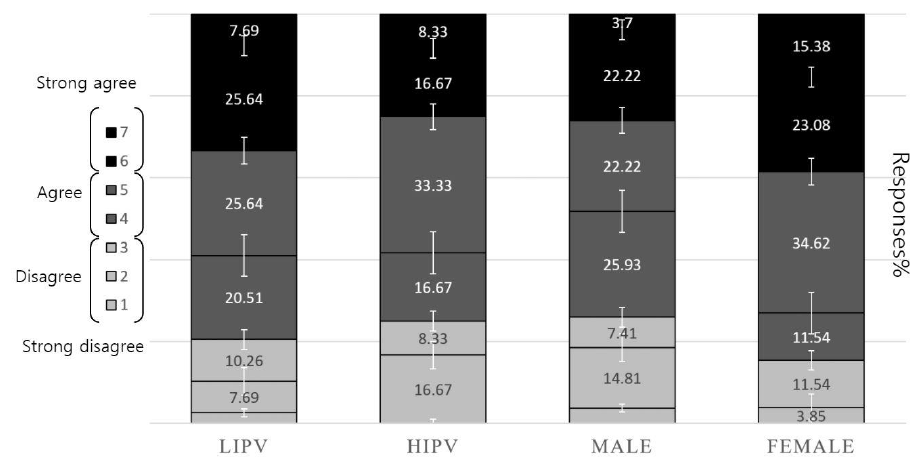
Figure 10. The level of enjoyment referred to the answers of (Post-Q.1) in post-questionnaire.